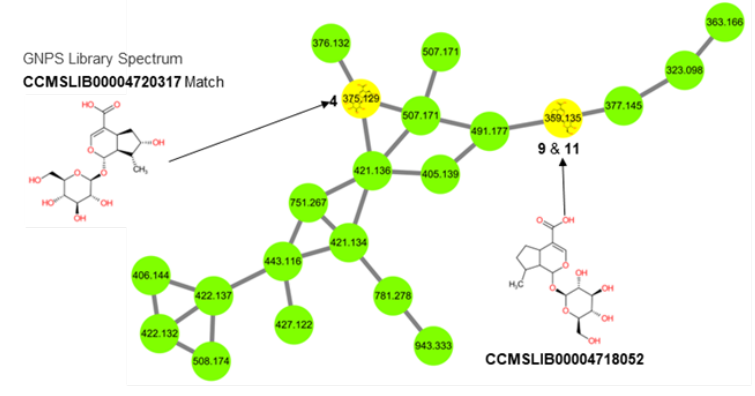
3 AEs for pediatric patients receiving antiangiogenic drugs ≥